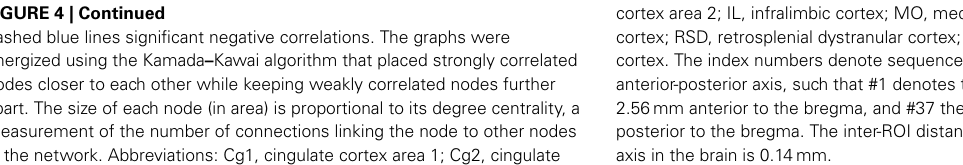
cortex area 2; IL, infralimbic cortex; MO, medial orbital cortex; PrL, prelimbic cortex; RSD, retrosplenial dystranular cortex; RSG, retrosplenial granular cortex. The index numbers denote sequence of ROIs along the anterior-posterior axis, such that #1 denotes the most anterior ROI at 2.56mm anterior to the bregma, and #37 the most posterior ROI at 2.48mm posterior to the bregma. The inter-ROI distance along the anterior- posterior axis in the brain is